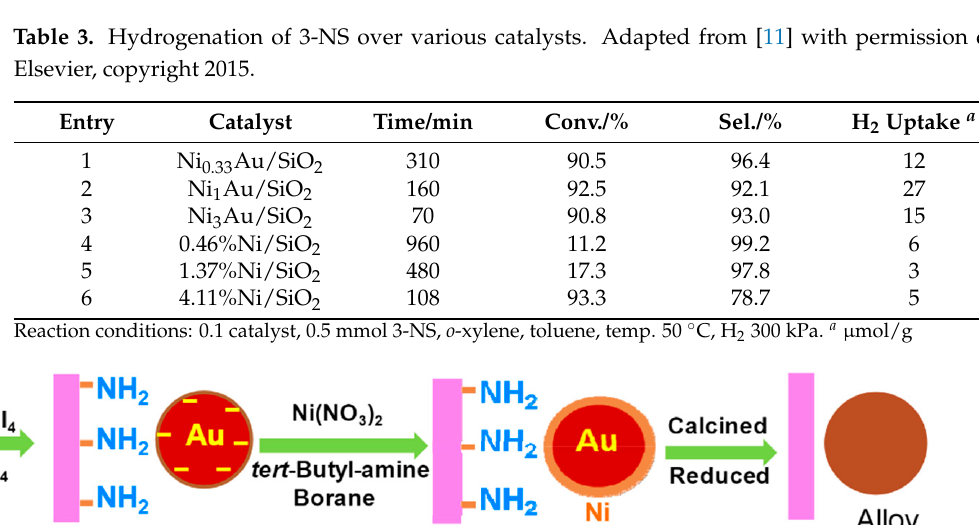
Table 3. Hydrogenation of 3-NS over various catalysts. Adapted from [11] with permission of Elsevier, copyright 2015.